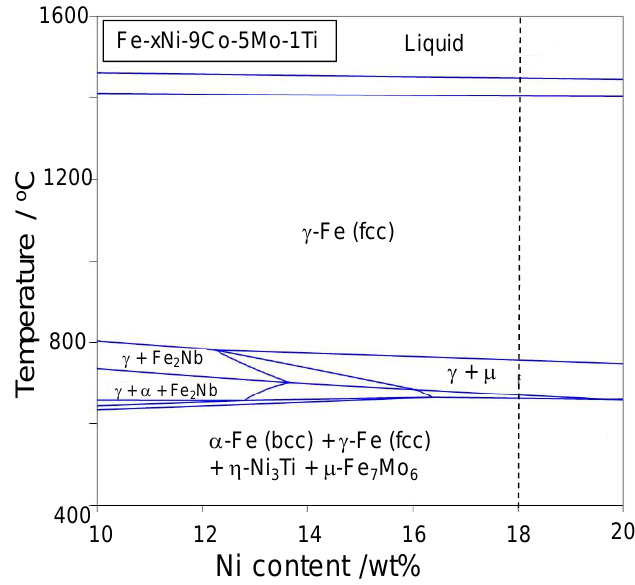
Figure 7. A composition of maraging steel studied on a vertical section of Fe–9Co–5Mo–1Ti (wt. %)